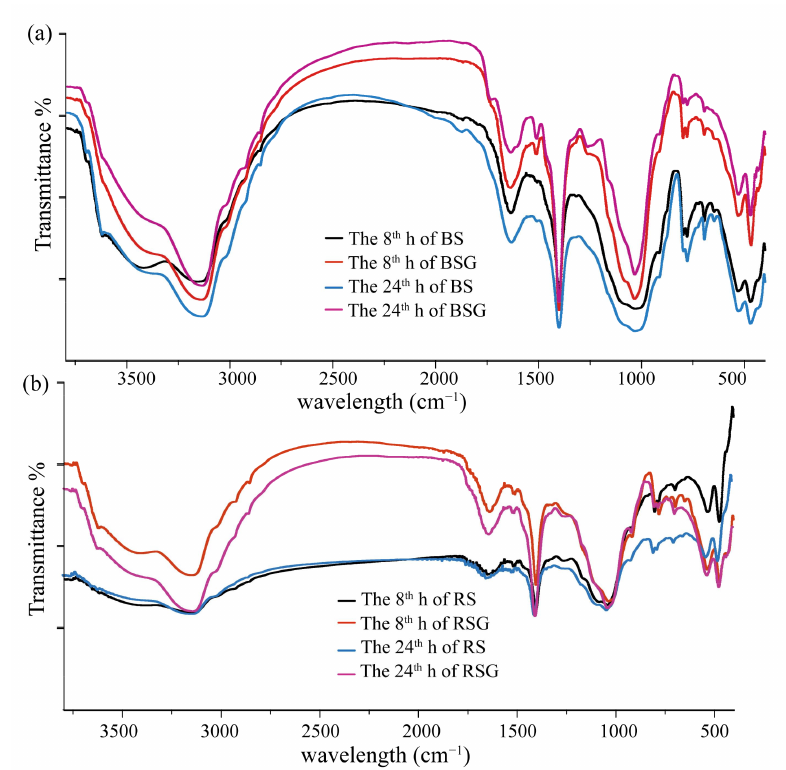
Figure 4. Transmittance at wavelengths within the Fourier-transform mid-infrared spectra (400–4000 cm − 1 ) of LFOM at the 8th h and 24th h. The ( a ) presented the BS and BSG pots, ( b ) showed the RS and RSG